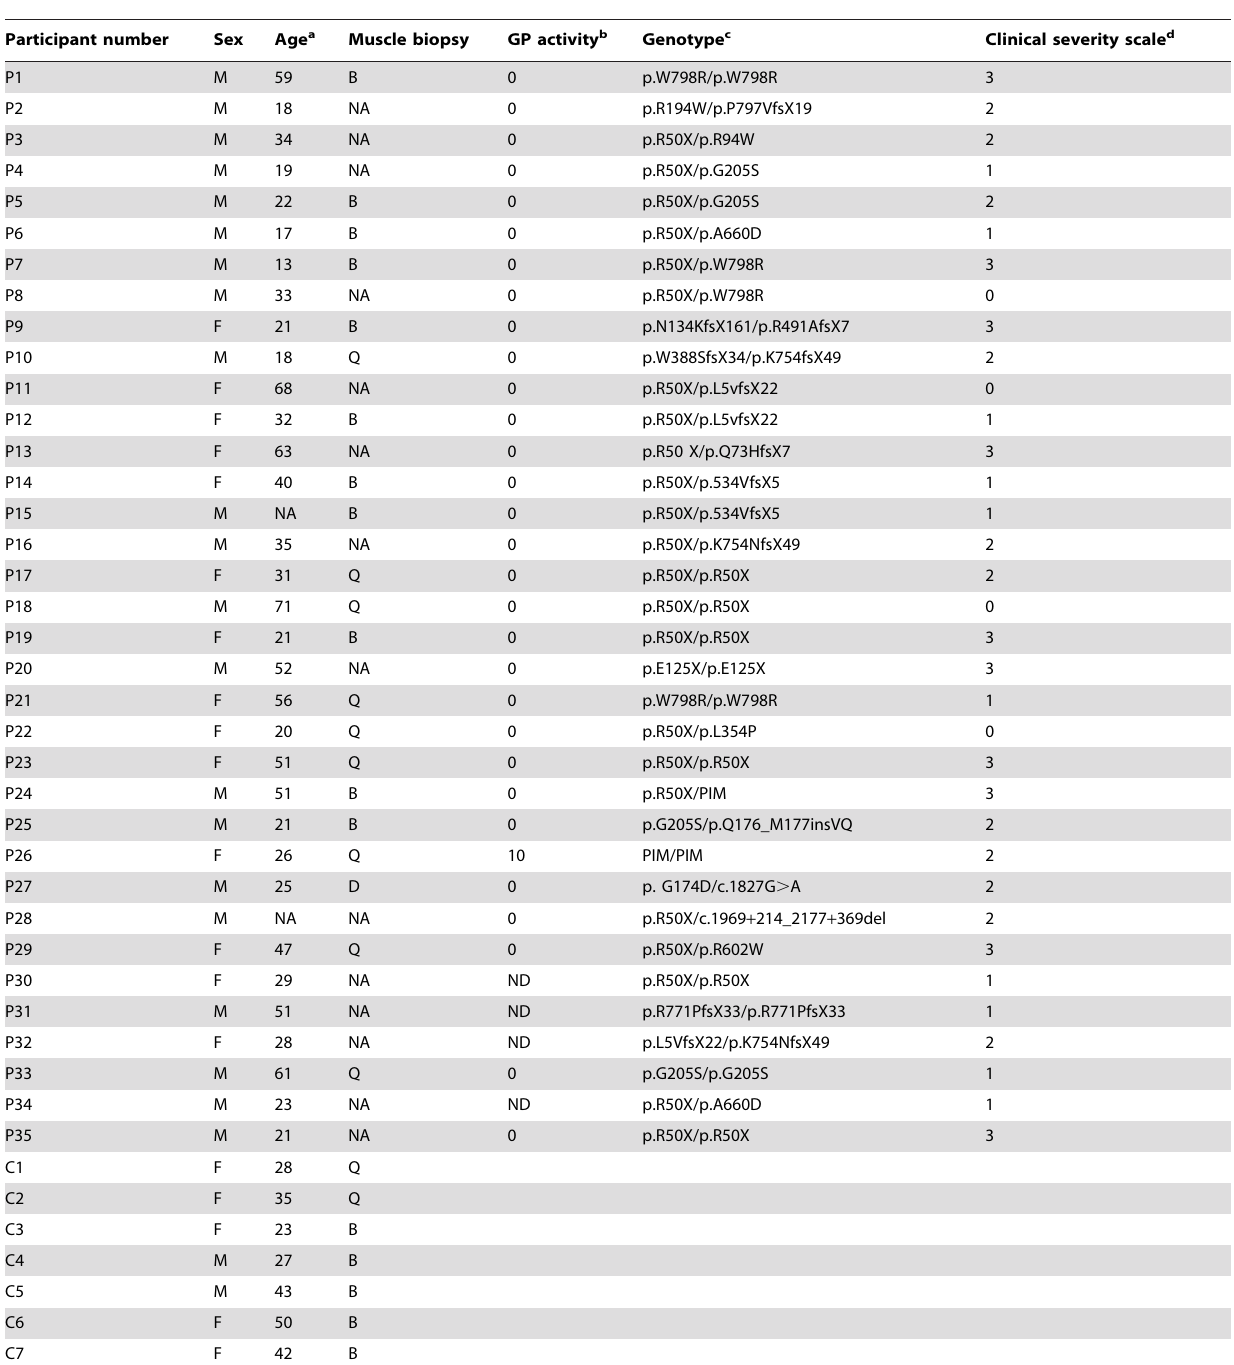
Table 1. Demographic data and information obtained by low-density array analysis in patients and healthy